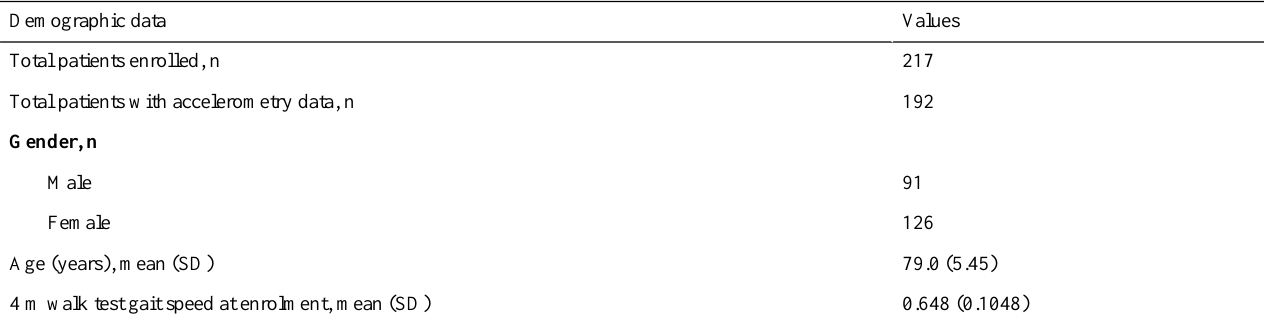
Table 2. A summary of demographic data for patients included in the interventional clinical